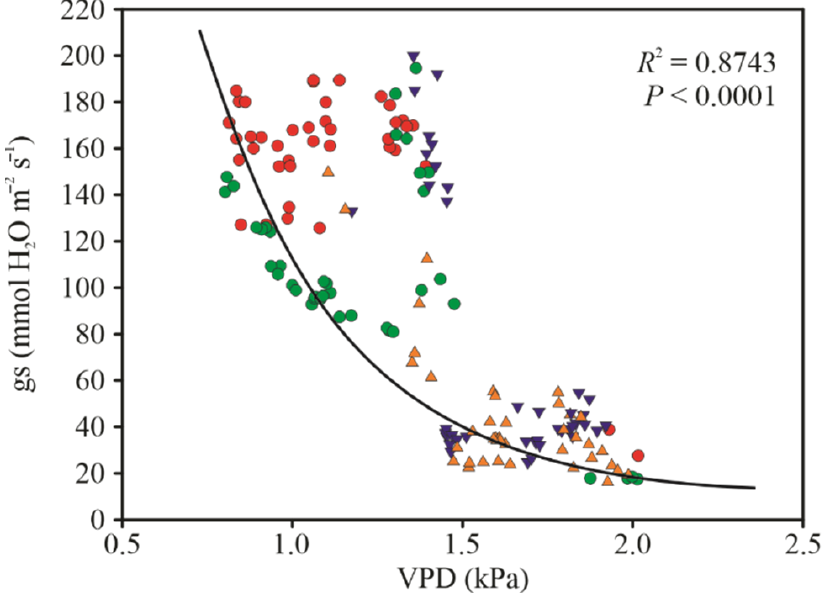
Figure 4. Relationship between VPD and g s measured at 08:00 and 12:00 h in dry and rainy season in four varieties (RB92579, red spheres; RB867515, green spheres; RB855536, blue triangle; and RB72454, orange triangle) of sugarcane. The black line represents the regression analysis. Each point denotes one sugarcane plant. Regression coefficient ( R 2 ) and p -value are shown. Figure 5 showed us that between 5:30 p.m. and 4:00 a.m. the sap flow in all variety is not significantly different with others. After predawn, the varieties start to show different patterns. While RB86715 rose moderately, accelerating later and from 2:30 p.m. showed a sharp drop, returning the initial values, the RB92579 showed a more delayed and continu- ous increase until 4:30 p.m. with no significant reduction in sap flow. These two varieties are considered to be more drought-tolerant than others (Figure 5A). The varieties RB855536 and RB72454 showed an increase in the sap flow from 5 a.m., but RB855536 showed a more abrupt rise than RB72454. However, while RB855536 start a drop in sap flow around 11:30 a.m. and showed an abruptly decrease to null sap flow from 1:00 p.m., the RB72454 season, all plants do not show a significant increase in its sap flow values (Figure 5B). The rate of sap flow in the rainy season was 2- to 5-fold higher than sap flow in the dry season, independent of the